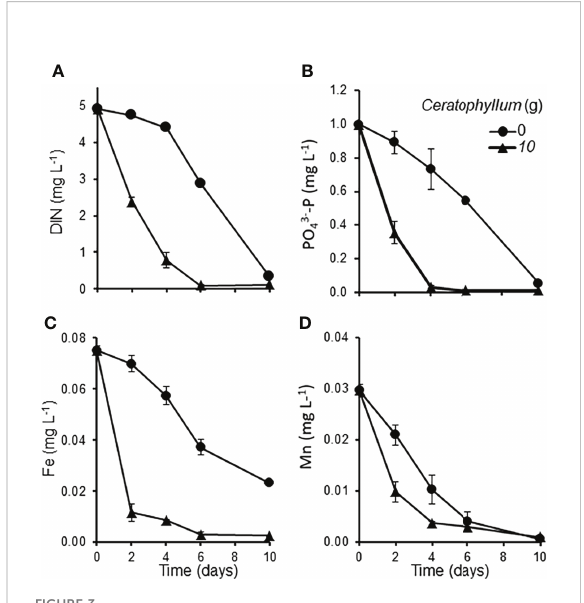
FIGURE 3 Nutrient concentrations in Lemna-Ceratophyllum co-cultures grown on static medium: (A) dissolved inorganic nitrogen (DIN: NH 4+ -N plus NO 3- -N), (B) PO 43 – P, (C) total iron (Fe), (D) total manganese (Mn) (means ± standard error, n =